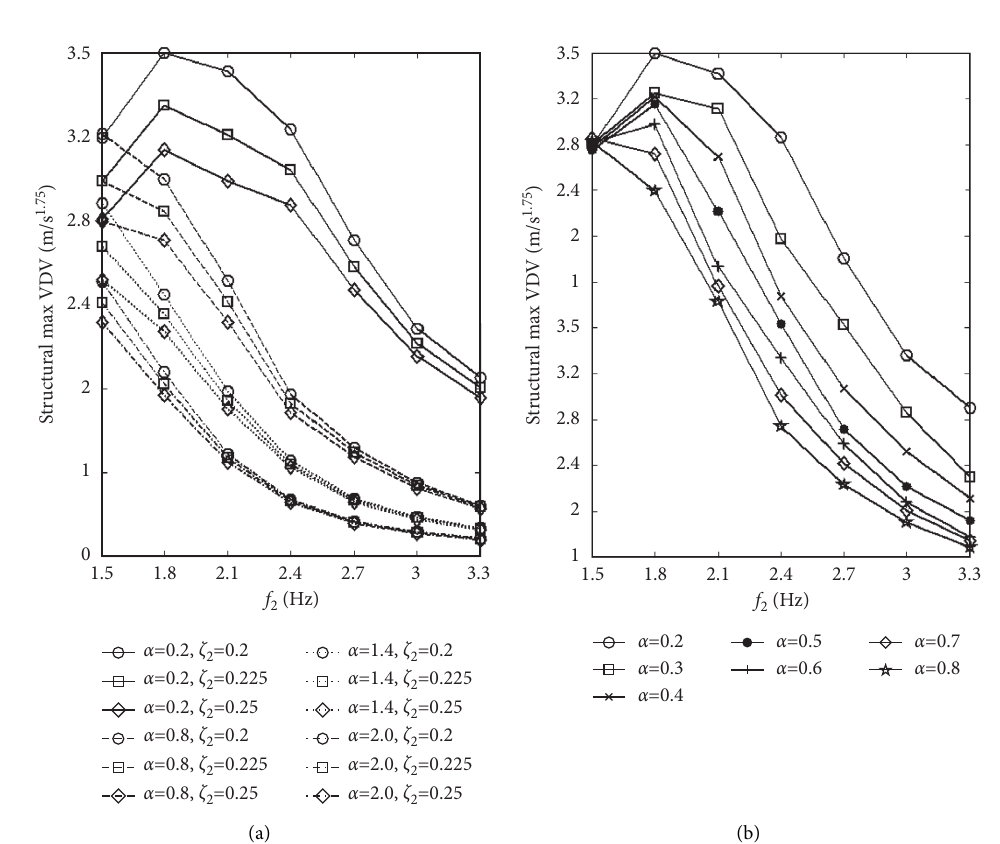
Figure 16: The influence of active crowd parameters on structural dynamic responses. (a) The max VDV with f α between 0.2 and